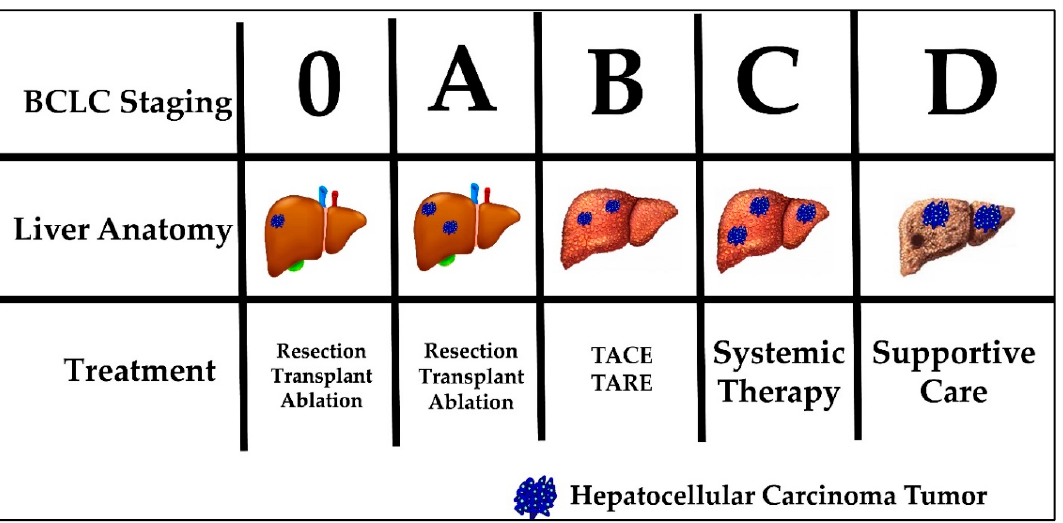
Figure 1. Barcelona Clinic Liver Cancer (BCLC) staging, liver anatomy, tumor burden and treatment.